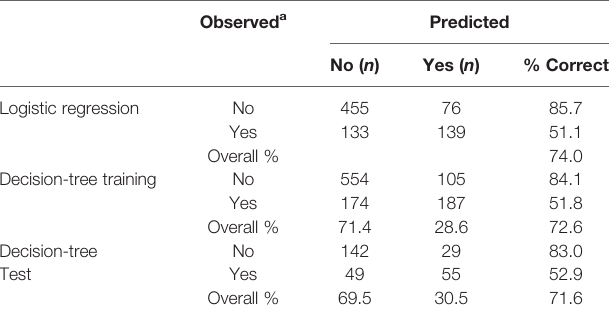
TABLE 4 | Predictive performance of logistic regression analysis and decision- tree model. Observed